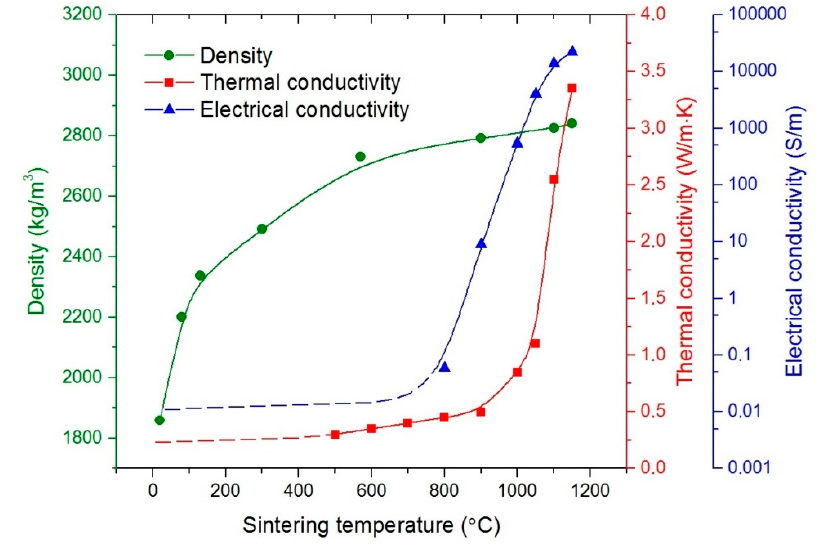
Figure 1. Dependence of electrical conductivity σ el , thermal conductivity κ and density ρ on sintering temperature of Si 80 Ge 20 samples.